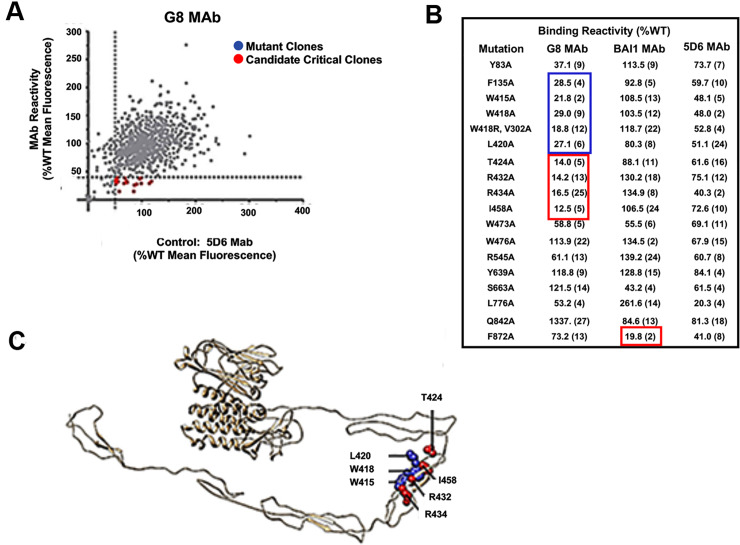
Identification of epitope of the G8 mAb.An alanine-scan library of BAI1 was constructed. The G8 and reference 5D6 mAbs were screened for binding to each individual BAI1 variant. A. Identification of candidate critical clones for G8 mAb binding was determined in duplicate by high throughput flow cytometry. For each point, background fluorescence was subtracted from the raw data that were then normalized to G8 reactivity with wild type BAI1. For each mutant clone, the mean binding value was plotted as a function of expression represented by control antibody reactivity. Candidate critical clones (red circles) were identified with a threshold (dashed line) of <40% binding of the G8 mAb and >50% of binding of the control 5D6 mAb to wild type BAI1. B. Identification of validated critical residues for G8 mAb binding. Candidate critical residues for G8 were rescreened in quadruplicate and the mean binding reactivities obtained. Validated critical residues for G8 binding (outlined in red) were residues whose mutations that resulted in <20% of wild type binding but positive (>70% binding) for binding of the 5D6 control mAb. Additional validated secondary residues (outlined in blue) were identified that did not meet the threshold guidelines but whose decreased binding activity and proximity to critical residues suggested that they may be part of the antibody epitope. C. Visualization of validated critical residues for G8 mAb binding. Critical residues (red spheres) and secondary residues (blue spheres) which may also contribute to binding were visualized on two Phyre-generated model structures that were combined to model BAI1 residues 262–934. The G8 critical residues were visualized on a model of the BAI1 thrombospondin repeat domains based on the structure of properdin (PDB ID# 1WOR; [15].